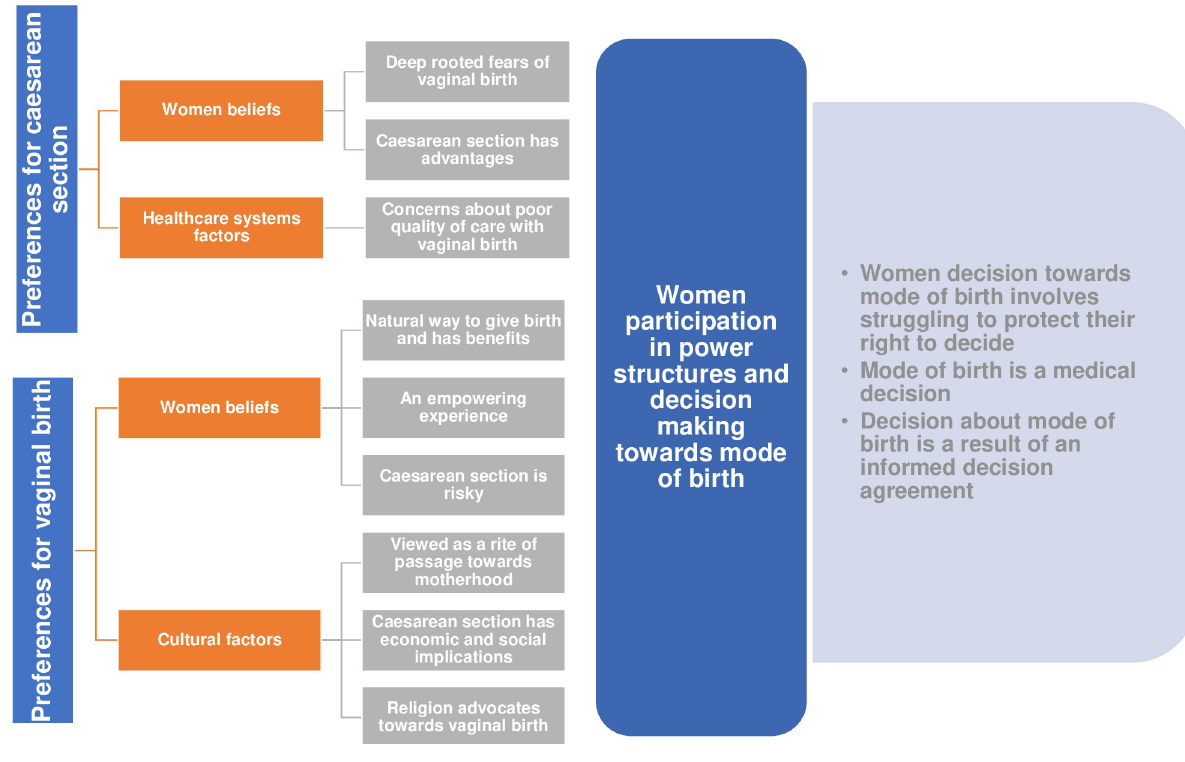
Fig 2. Summary of